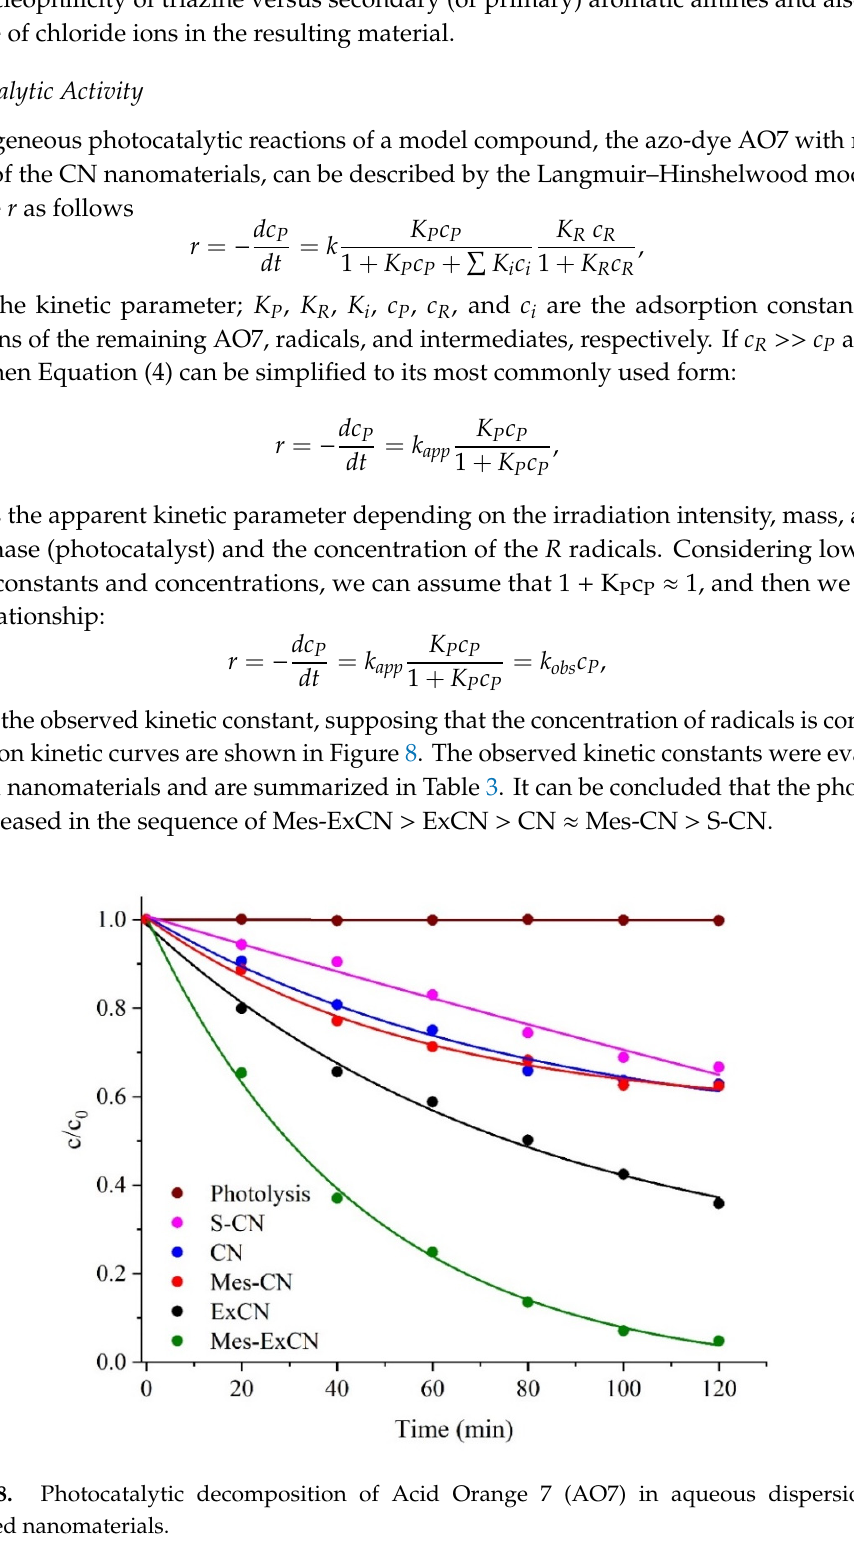
Table 3. Observed kinetic constants and specific surface area (SSA) of CN-based nanomaterials. AO7, Acid Orange 7.